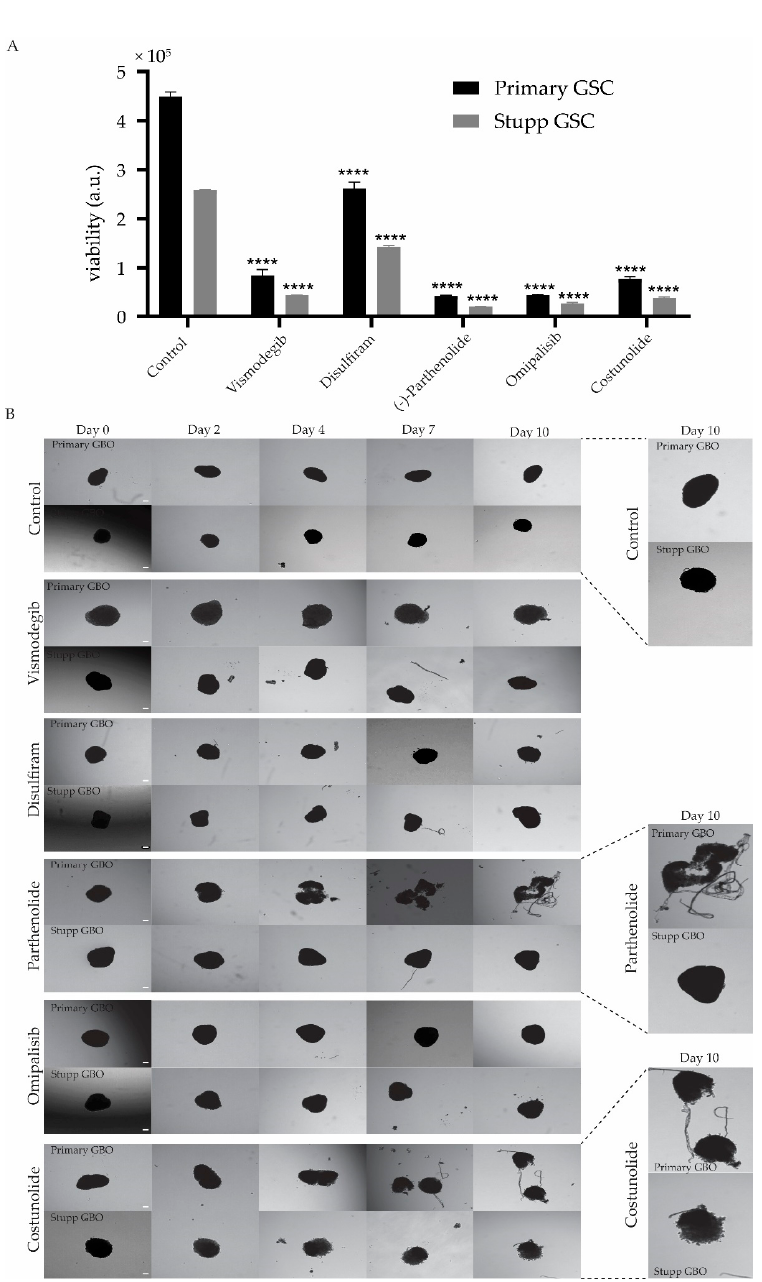
Figure 6. Response to second line treatment of treatment naïve and resistant glioblastoma. ( A ) Primary and Stupp G18-T cell line response to the addition of Vismodegib, Disulfiram, Parthenolide, Omipalisib or Costunolide. Data represent cell viability for each treatment group with the addition of each of the five selected drugs. Data are mean ± SEM for four replicates. All treatment groups were compared with their respective group (primary or Stupp) control (**** p < 0.0001, TWO-WAY ANOVA with Sidak correction for multiple comparisons). ( B ) GBO response to the addition of selected drugs. Brightfield images of primary GBO (untreated) and Stupp GBO (TMZ+radiation treated) with additional treatment with each selected drug over the 10-day treatment period, with Day 0 images taken before the start of the treatment. Scale bar 0.1 mm. Magnified images of primary and Stupp GBO for Control, Parthenolide and Costunolide treatment are also